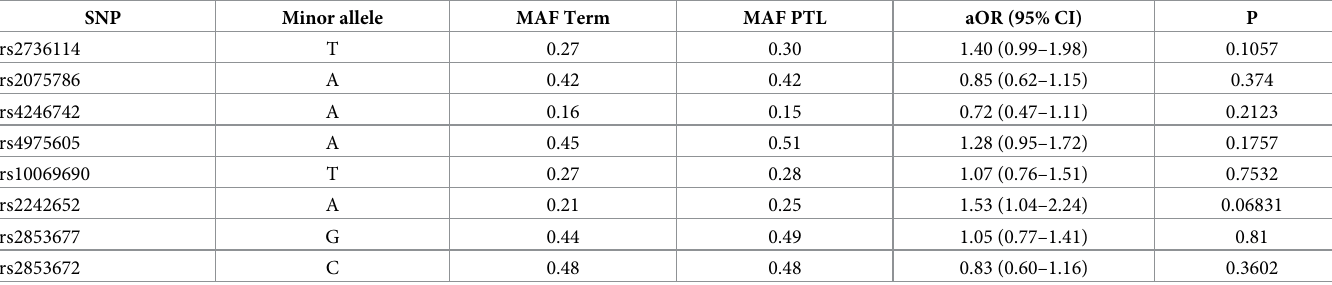
Table 6. Logistic regression results for fetal single locus allele frequencies among cases and controls and association with preterm labor.